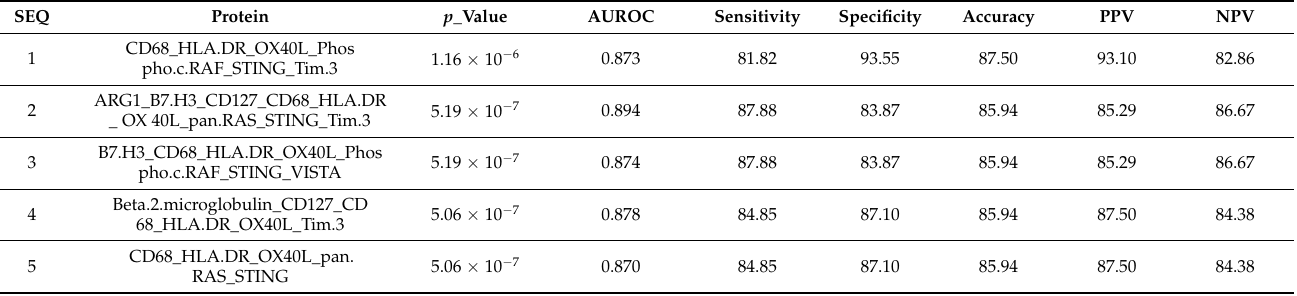
Table 3. Candidate protein signatures derived from